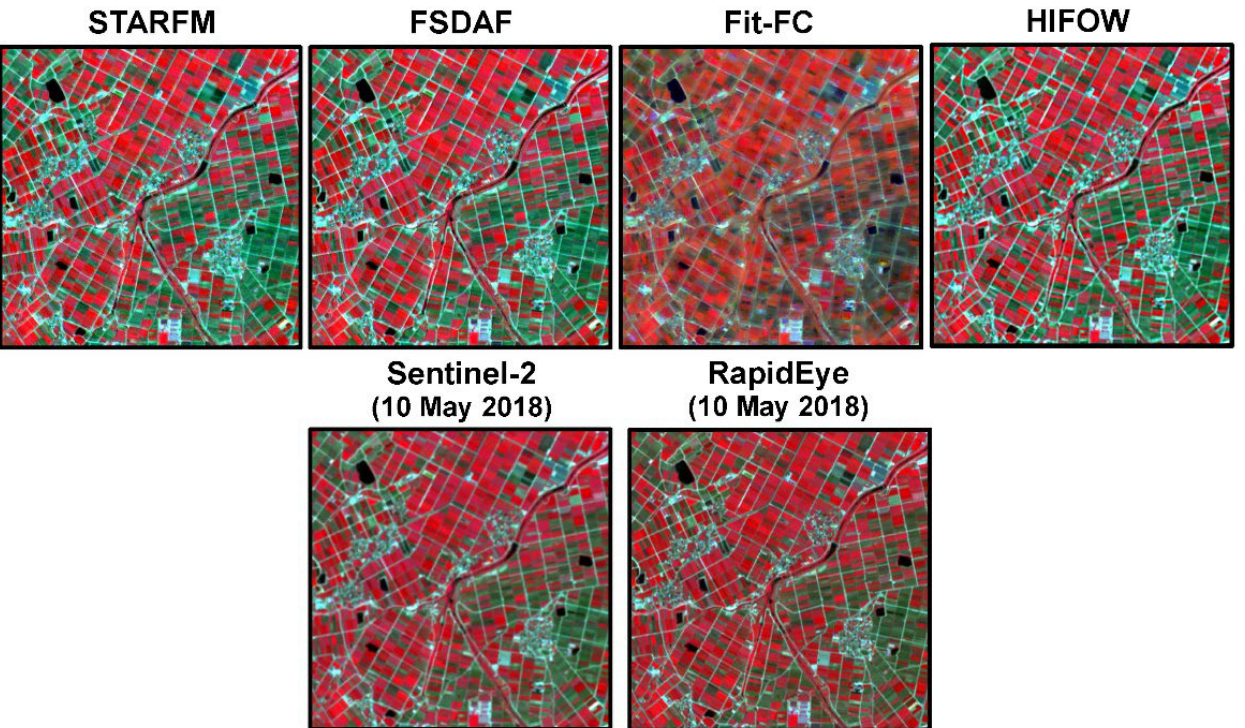
Figure 6. Prediction results of different STIF models with Sentinel-2 and RapidEye images at the prediction date (10 May 2018) at Site 1. All color composite images are displayed with NIR-red- green as RGB.